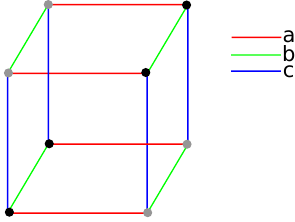
Figure 4: An example of O